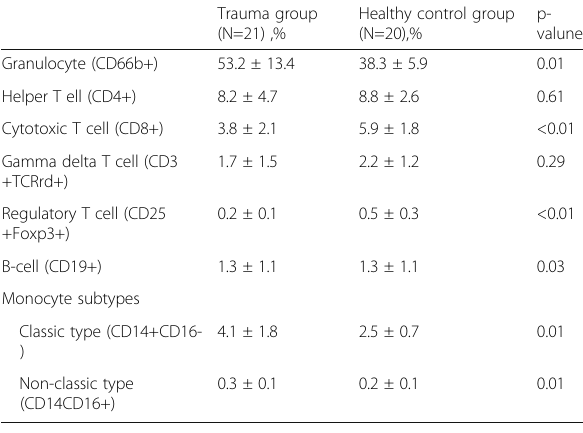
Table 1 (abstract 0013). serial comparison of immune cells (hospital day -